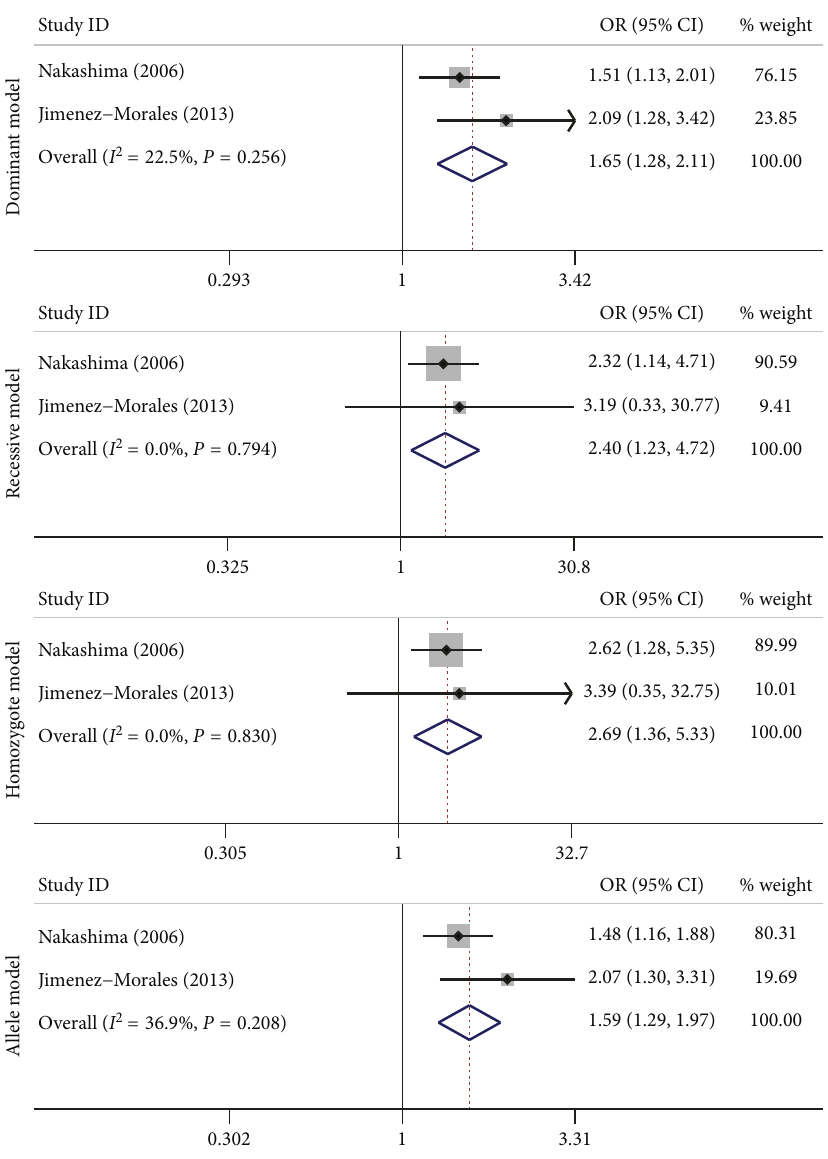
Figure 4: Forest plots of the association between the MMP-9 Arg668Gln, rs17577 polymorphism and risk of asthma in the dominant model, recessive model, homozygote model, and allele model